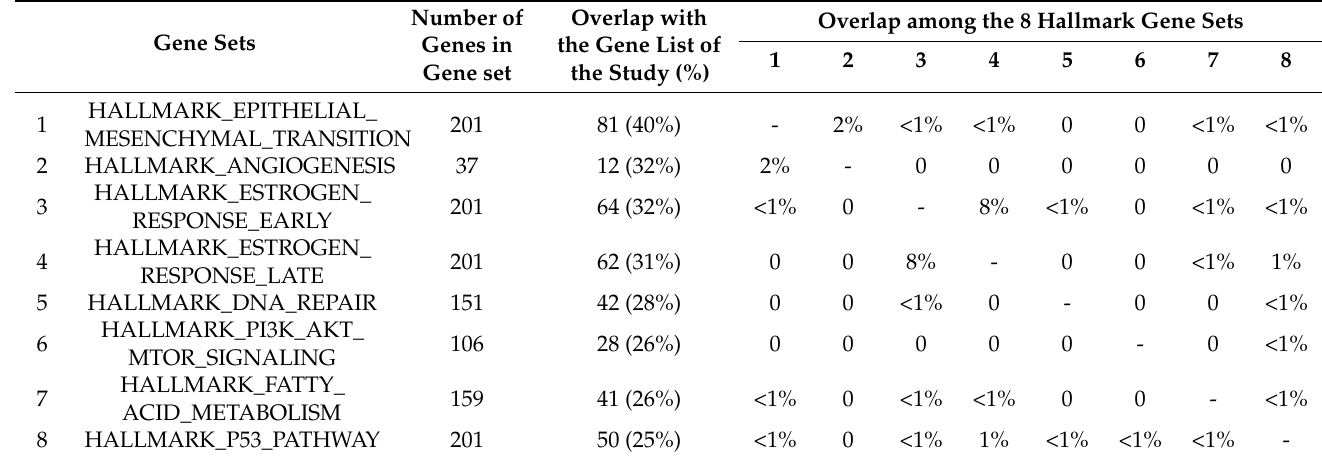
Table 2. The hallmark gene sets of cancer selected for this study. Number of Gene Sets Genes in Gene